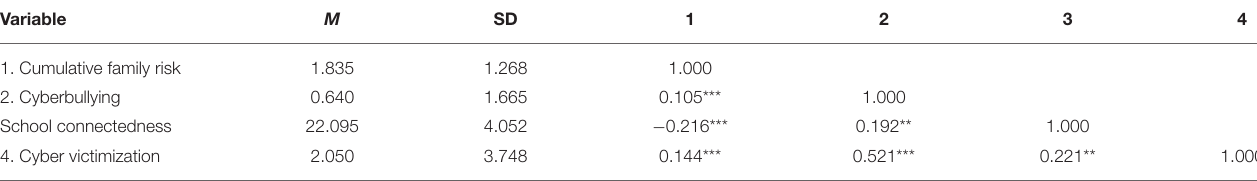
TABLE 2 | Descriptive statistics and interrelations among variables. Variable